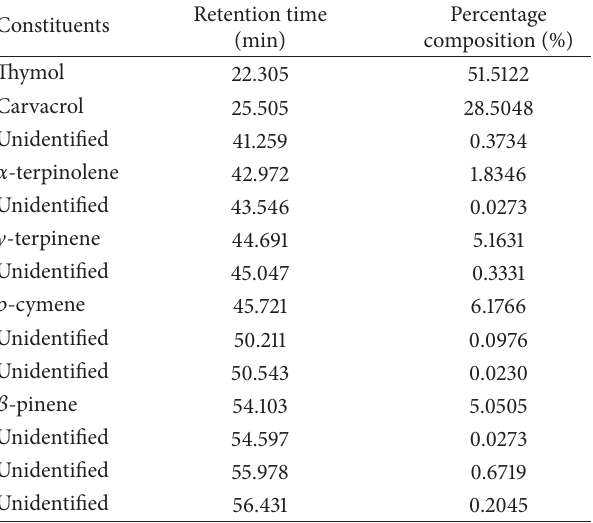
Table 2: Chemical constituents of fruit essential oil of Trachysper- mum ammi